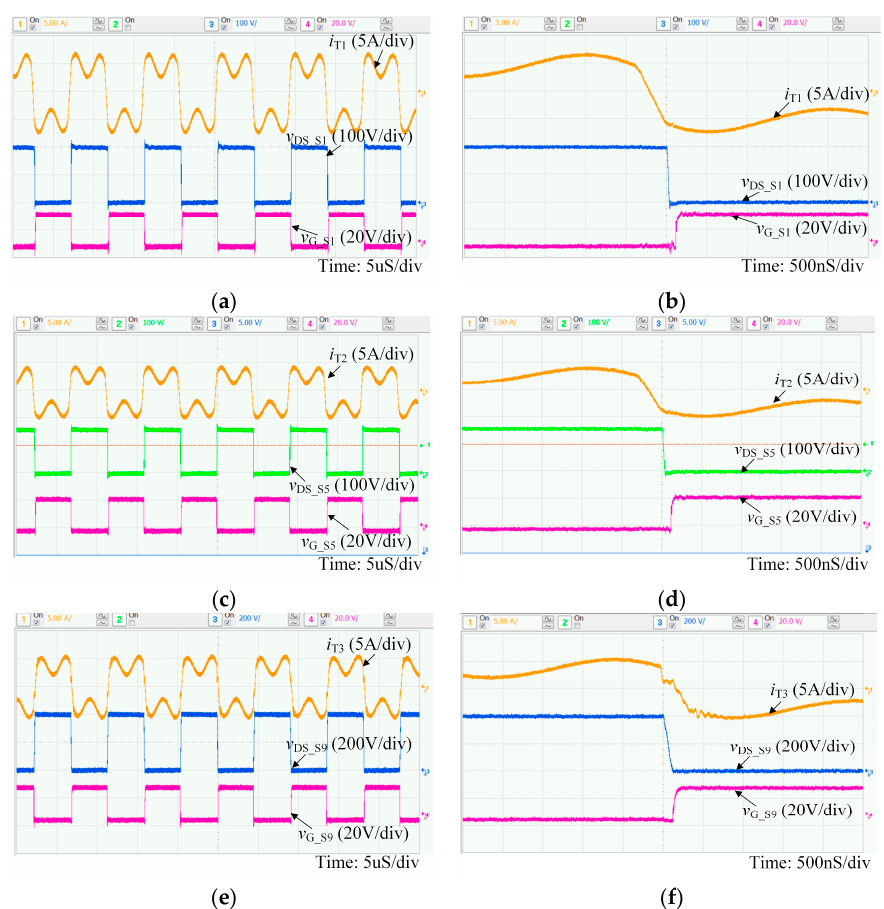
Figure 16. Experimental results of MR-TP-BDC under reverse rated condition: ( a , b ) port 1; ( c , d ) port 2; ( e , f ) port 3.